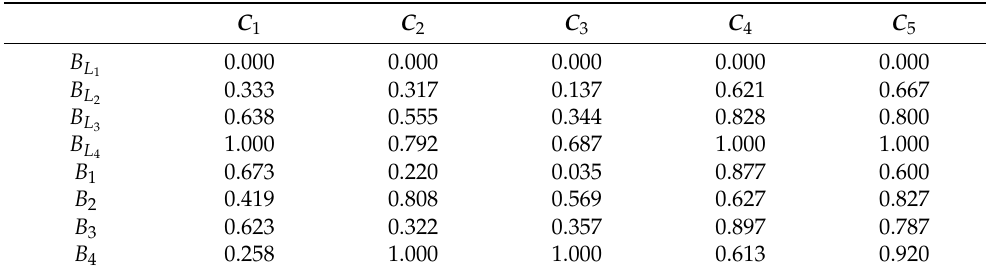
Table 6. Significance degree.